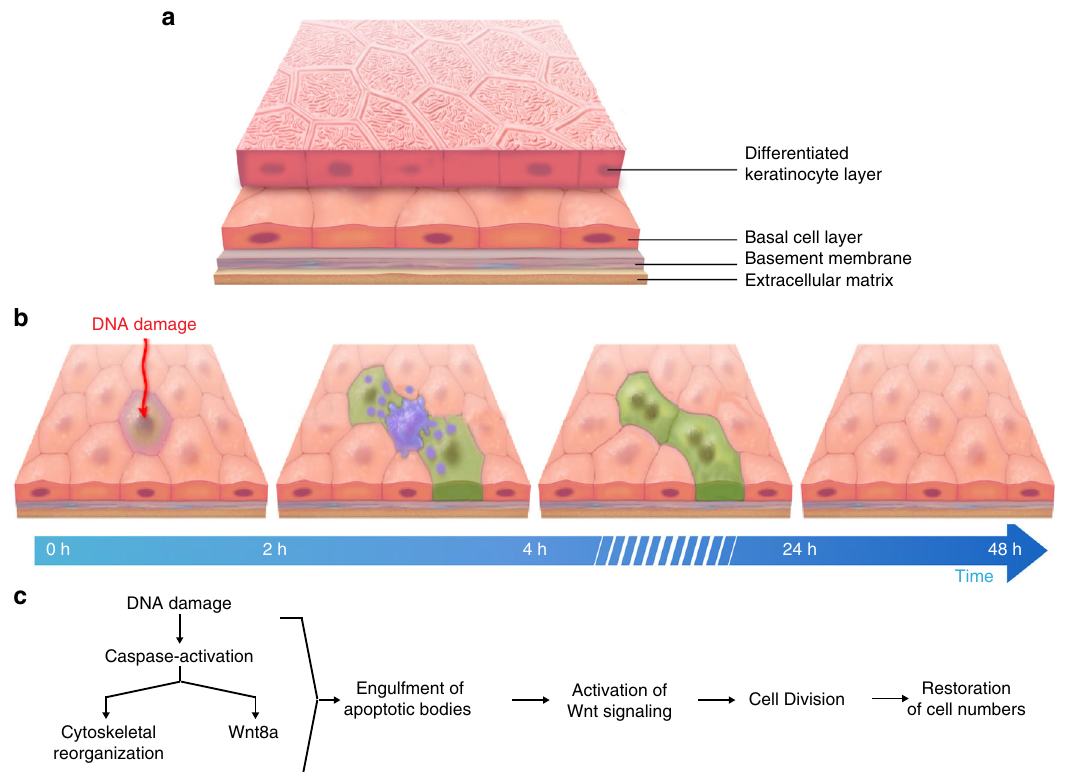
Fig. 6 Model of apoptosis-induced stem cell turnover in an epithelial bilayer. a Schematic of an epithelial bilayer. b Sequence of cellular events observed by time-lapse imaging. c Temporal activation of distinct molecular mechanisms promoting the replacement of lost